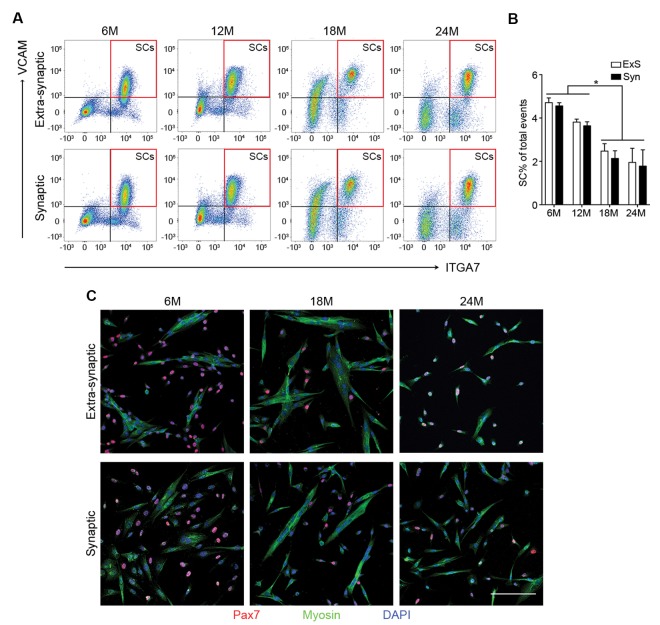
Age-related SC decline occurs to a similar extent between synaptic and extra-synaptic diaphragm regions.(A) Representative FACS plots of cells isolated from 6/12/18/24-month-old C57BL6/J synaptic and extra-synaptic diaphragms. Red boxes represent the gate for the SC population. (B) Quantification of FACS-purified SC percentage of total events from synaptic (Syn) and extra-synaptic (ExS) regions of diaphragms. *p<0.05 compared to 6M/12M groups, two-way ANOVA/Sidak multiple comparison test. (C) Representative images of FACs-sorted SC cultures stained for Pax7 (red), Myosin (green), and DAPI (blue). Scale bar = 100 μm. n = 3 (24M-ExS, 24M-Syn); 4 (6M-ExS, 6M-Syn, 12M-ExS, 12M-Syn) or 7 (18M-ExS, 18M-Syn) mice (B).